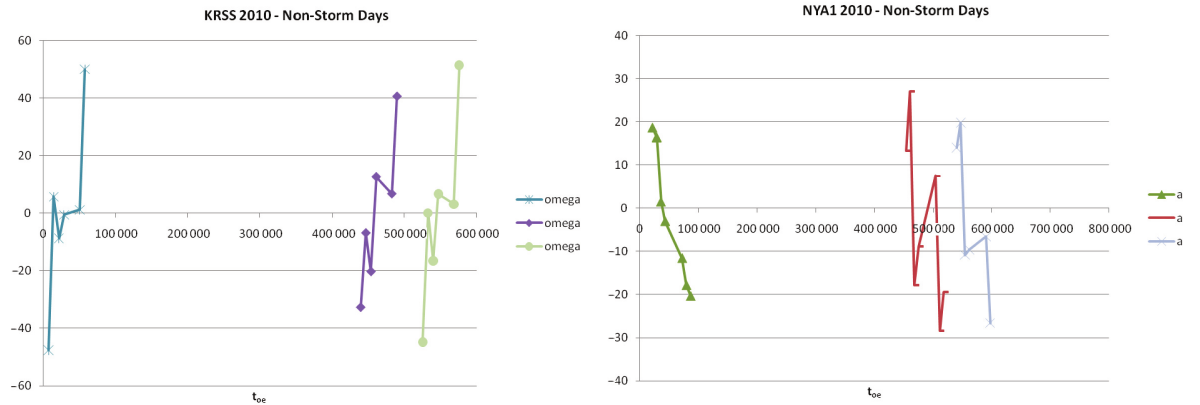
Fig. 18. a semi-major axis of three stormless days in 2010 using cPOS stations (NYa1)